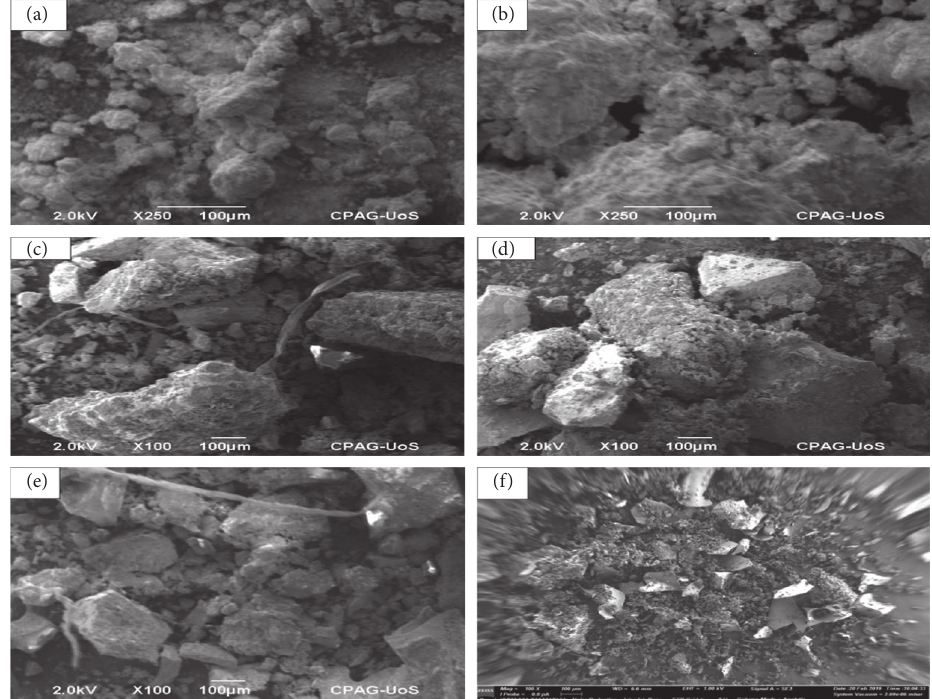
Figure 5: SEM images of LDH (a), C-1 (b), C-2 (c), C-3 (d), C-4 (e), and HC (f).